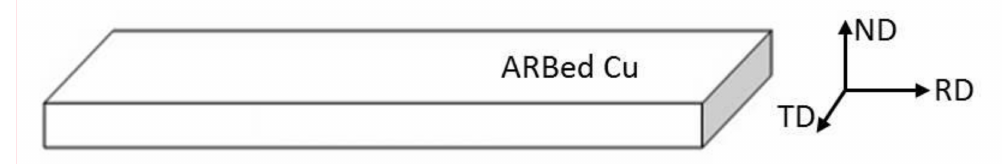
Figure 1. Schematic representation of the ARBed Cu plates with RD, ND, and TD coordinate